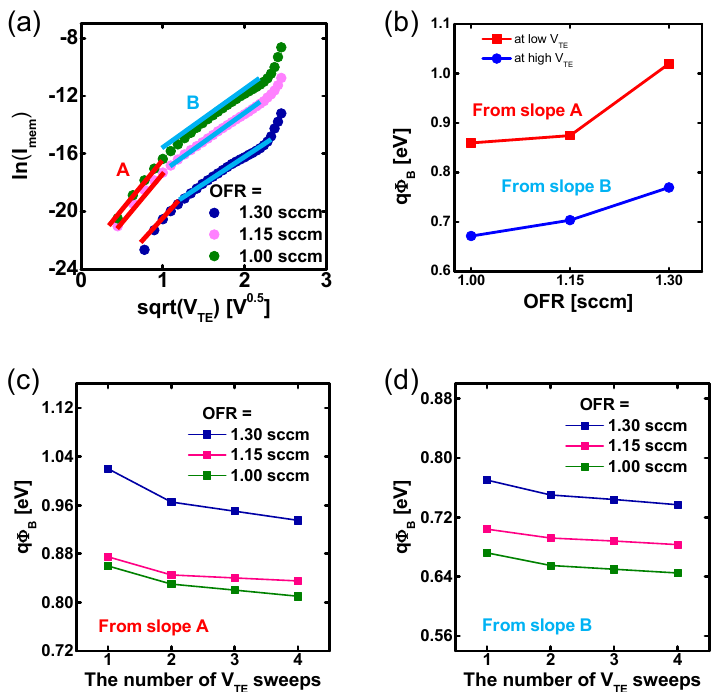
Figure 3. ( a ) The OFR-dependent ln( I mem ) − ( V TE ) 1 / 2 relationships. ( b ) The OFR-dependent Φ B extracted at low and high V TE . The Φ B modulation depending on the number of V SS from the slopes ( c ) A at high V TE and ( d ) B at low V TE .